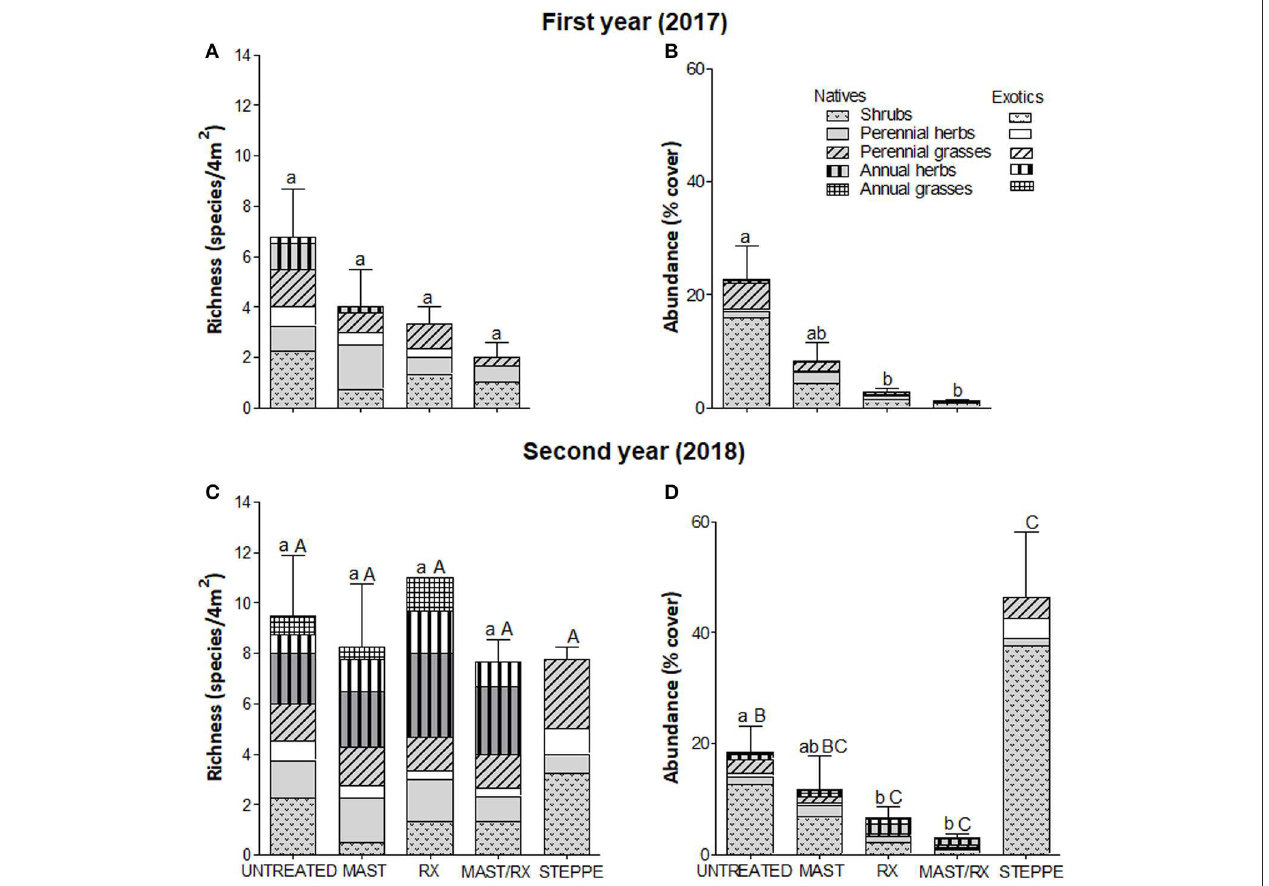
FIGURE 5 | Vegetation richness (A,C) and abundance (B,D) by origin and growth form in each fuel treatment for the first (A,B) and the second (C,D) years; steppe vegetation variables are included for the second year in site 2. Bars indicate total richness and abundance SE , respectively. Different small letters indicate differences among fuel treatments for each year (differences among years for each fuel treatment are not represented), and capital letters indicate differences among fuel treatments and steppe. Treatments are as follows: residues on the floor (UNTREATED), mastication (MAST), prescribed fire (RX), mastication plus prescribed fire (MAST/RX), and steppe vegetation